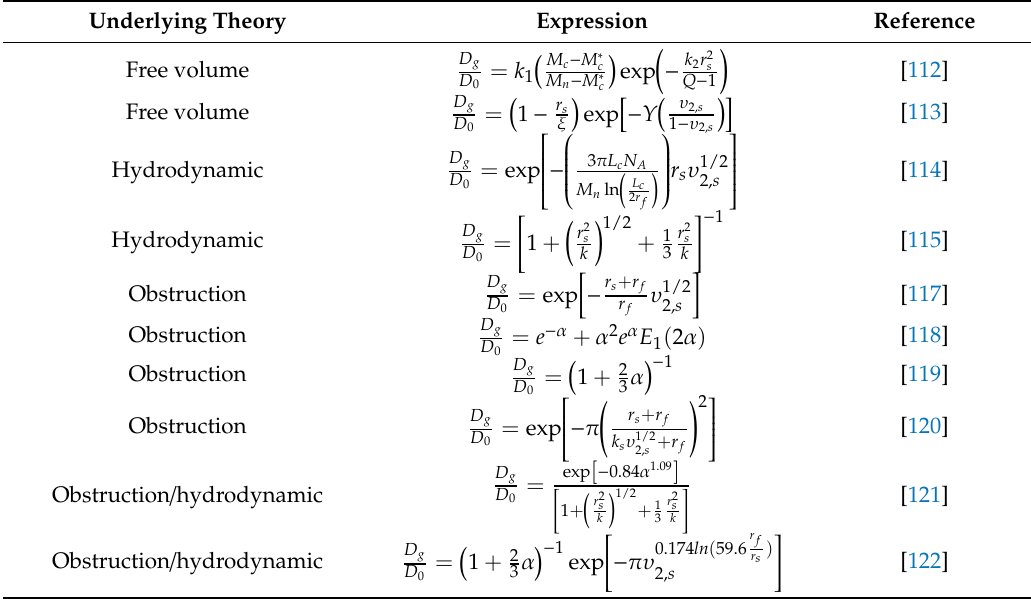
Table 3. Models for di ff usion coe ffi cients in